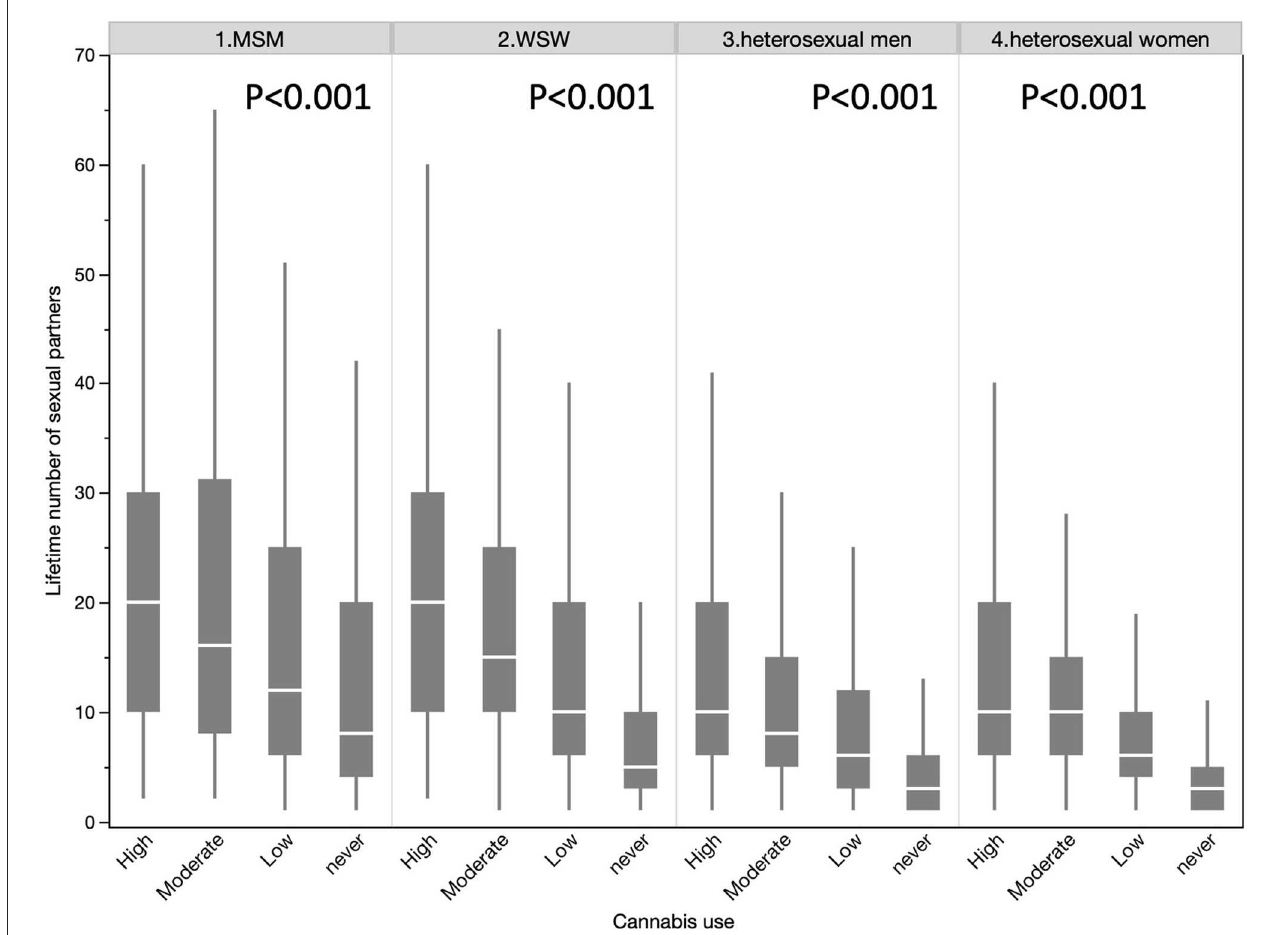
FIGURE3 Lifetime number of sexual partners in all the subgroups according to cannabis